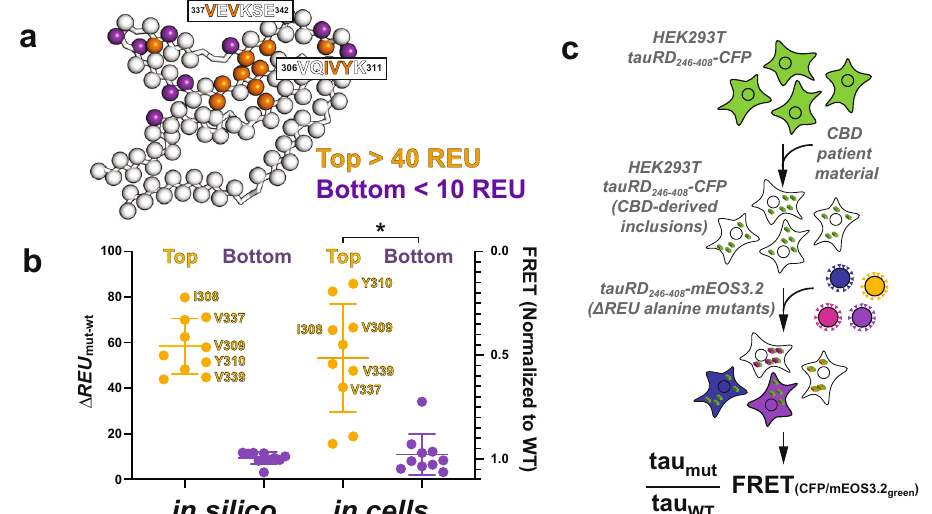
Fig.5|ExperimentalvalidationofpredictedCBDhotspots.a Cartoonschematic (Range from 1.0=no change in FRET, i.e., no effect on the ability of mutant tau to aggregate in biosensor cellswhen seeded with CBD-derivedseedsascompared to to evaluate the importance of key amino acids in cellulartau seeding experiments the WT, to 0.0=no FRET observed, i.e., mutant tau is unable to induce FRET- using CBD patient tissues. Orange residues are predicted to be important to fi bril detectable aggregation in the biosensor). The experiment was performed in tri- stability (normalized Δ REU assembly mut (cid:1) wt >40), while purple residues are predicted to be plicate and the data are shown as averages with standard deviations. The experi- minimally important to fi bril stability (normalized Δ REU assembly mut (cid:1) wt <10). b Plot com- mental top and bottom hits are shown to be signi fi cantly different with p -value paring the top-10 and bottom-10 most important residues as determined by Δ REU assembly Δ REU assembly 0.0016 ( U =2.0)using a two-tailed Mann – Whitney test and are indicatedby a star. mut (cid:1) wt fromtheinsilicoalaninescan(scaledfromnormalized0 mut (cid:1) wt , The fi bril incorporation assay was performed once. c Cartoon schematic showing i.e.,nopredictedlossin fi brilstabilitycausedbyalaninemutanttonormalized100 — high predicted loss in fi bril stability due to alanine mutant), along- Δ REU assembly the method of the in vitro, FRET biosensor-based tau seeding cell assay used to mut (cid:1) wt side the effect of these alanine mutants on the ability of CBD-brain derived tau assess the impact of mutants on tau ’ s ability to aggregate when seeded by pro- seeds to seedaggregation asmeasured bythe biosensor-based aggregation assay. teopathic tau